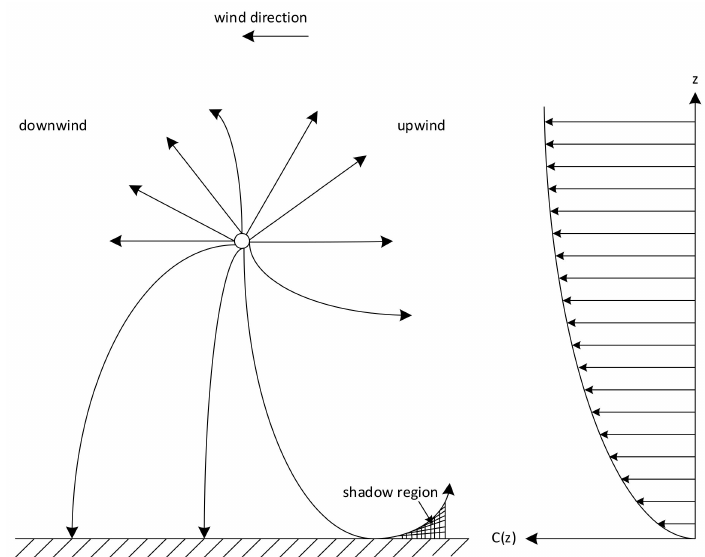
Figure 4. Refraction of sound due to wind gradient. Adapted from [19].